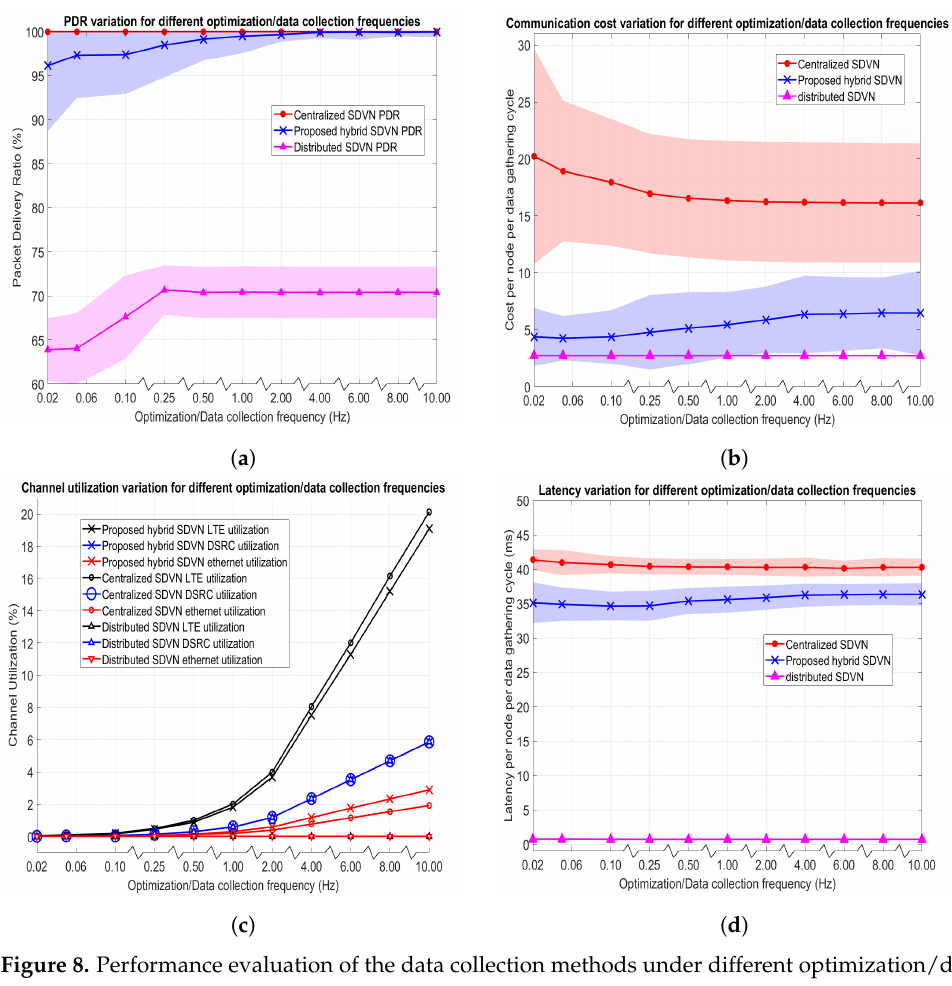
Figure 8. Performance evaluation of the data collection methods under different optimization/data collection frequencies. ( a ) Packet delivery ratio variation for different optimization/data collec- tion frequencies; ( b ) Communication cost per node per data-gathering cycle variation for different optimization/data collection frequencies; ( c ) Average channel utilization per data-gathering cycle variation for different optimization/data collection frequencies; ( d ) End to end latency per node per data-gathering cycle variation for different optimization/data collection